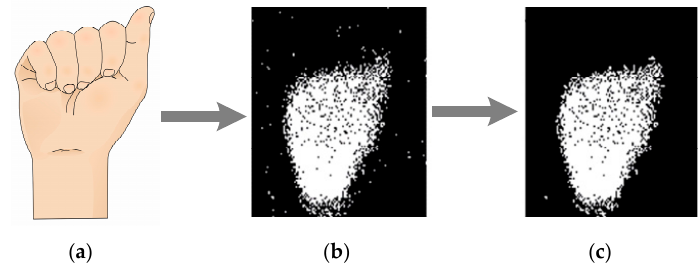
Figure 4. Image to event transition and events filtering of “A” sign, ( a ) ASL ； alphabet sign ( b ) raw data ； sent by the neuromorphic sensor ( c ) image after filtering.